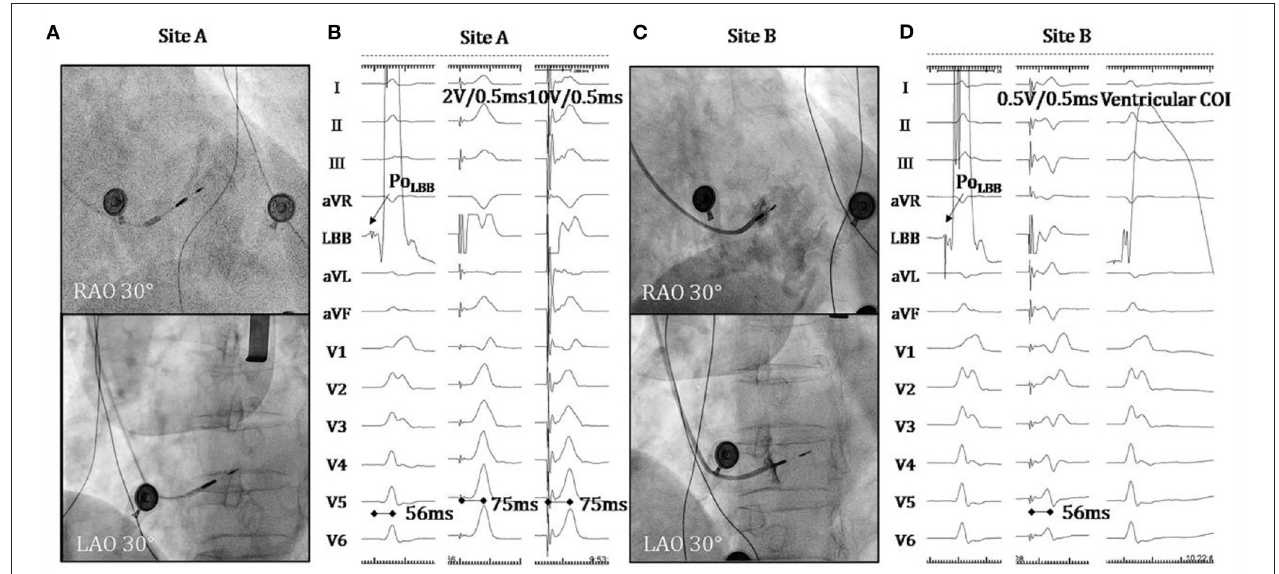
FIGURE 1 | (A) Fluoroscopic images at RAO 30 ◦ and LAO 30 ◦ at the site A which represents where the pacing lead got for the first time. (B) The LBB potential noted and the characteristics of paced QRS morphology at the site A. (C) Fluoroscopic images at RAO 30 ◦ and LAO 30 ◦ at the site B. (D) The LBB potential noted, the characteristics of paced QRS morphology and ventricular COI at the site B. RAO, right anterior oblique; LAO, left anterior oblique; LBB, left bundle branch; COI, current of